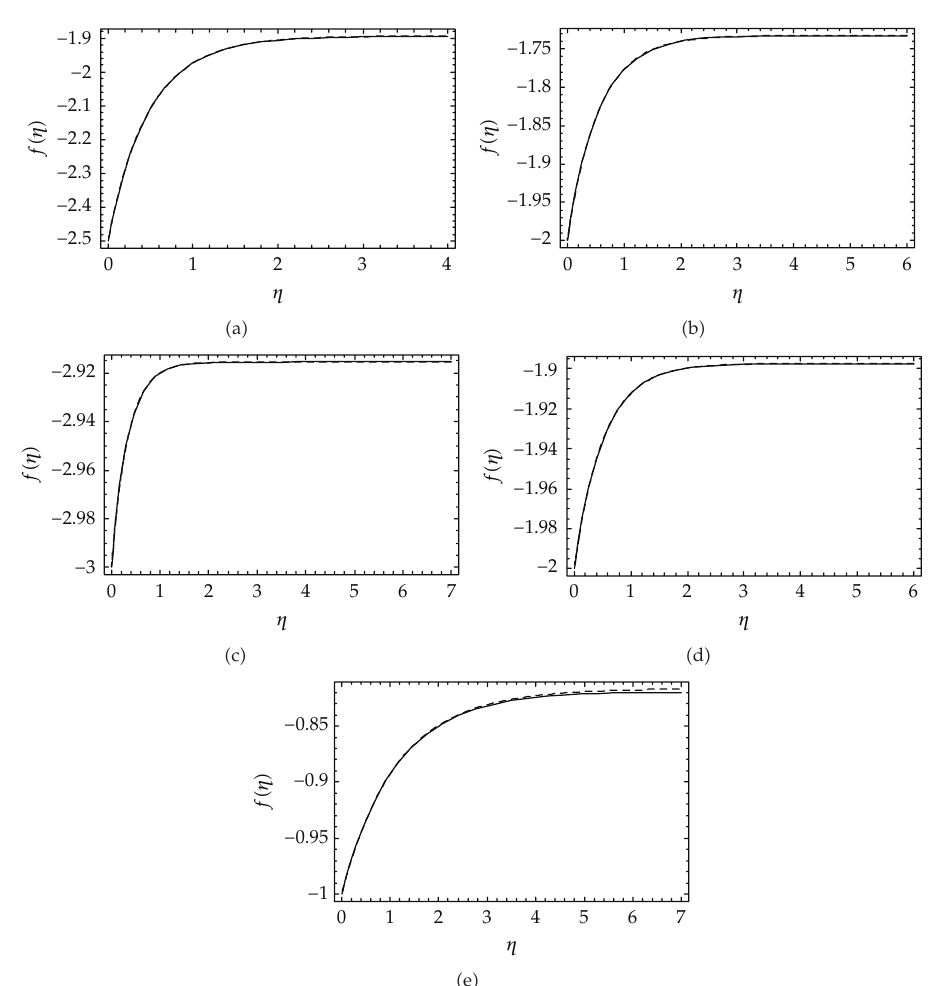
Figure 6: Profiles of the similar stream function f (cid:3) η (cid:4) as a function of η at m (cid:8) − 1 , σ (cid:8) 0 in R 1 for (cid:3) a (cid:4) λ (cid:8) − 0 . 1 and s (cid:8) − 2 . 5, (cid:3) b (cid:4) λ (cid:8) 0 . 5 and s (cid:8) − 2, (cid:3) c (cid:4) λ (cid:8) 1 and s (cid:8) − 3, (cid:3) d (cid:4) λ (cid:8) 2 and s (cid:8) − 2, and (cid:3) e (cid:4) λ (cid:8) 5 and s (cid:8) − 1, where solid and dashed lines are for ChPDM and G (cid:2) /G -expansion solutions, respectively.